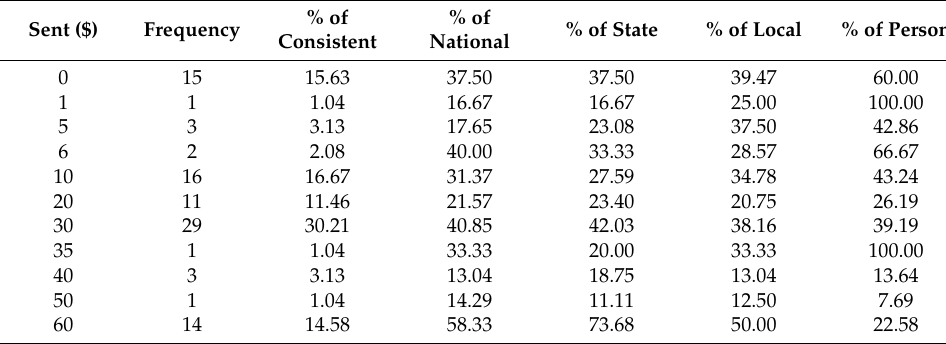
Table A4. Distribution of amounts sent by consistent givers.